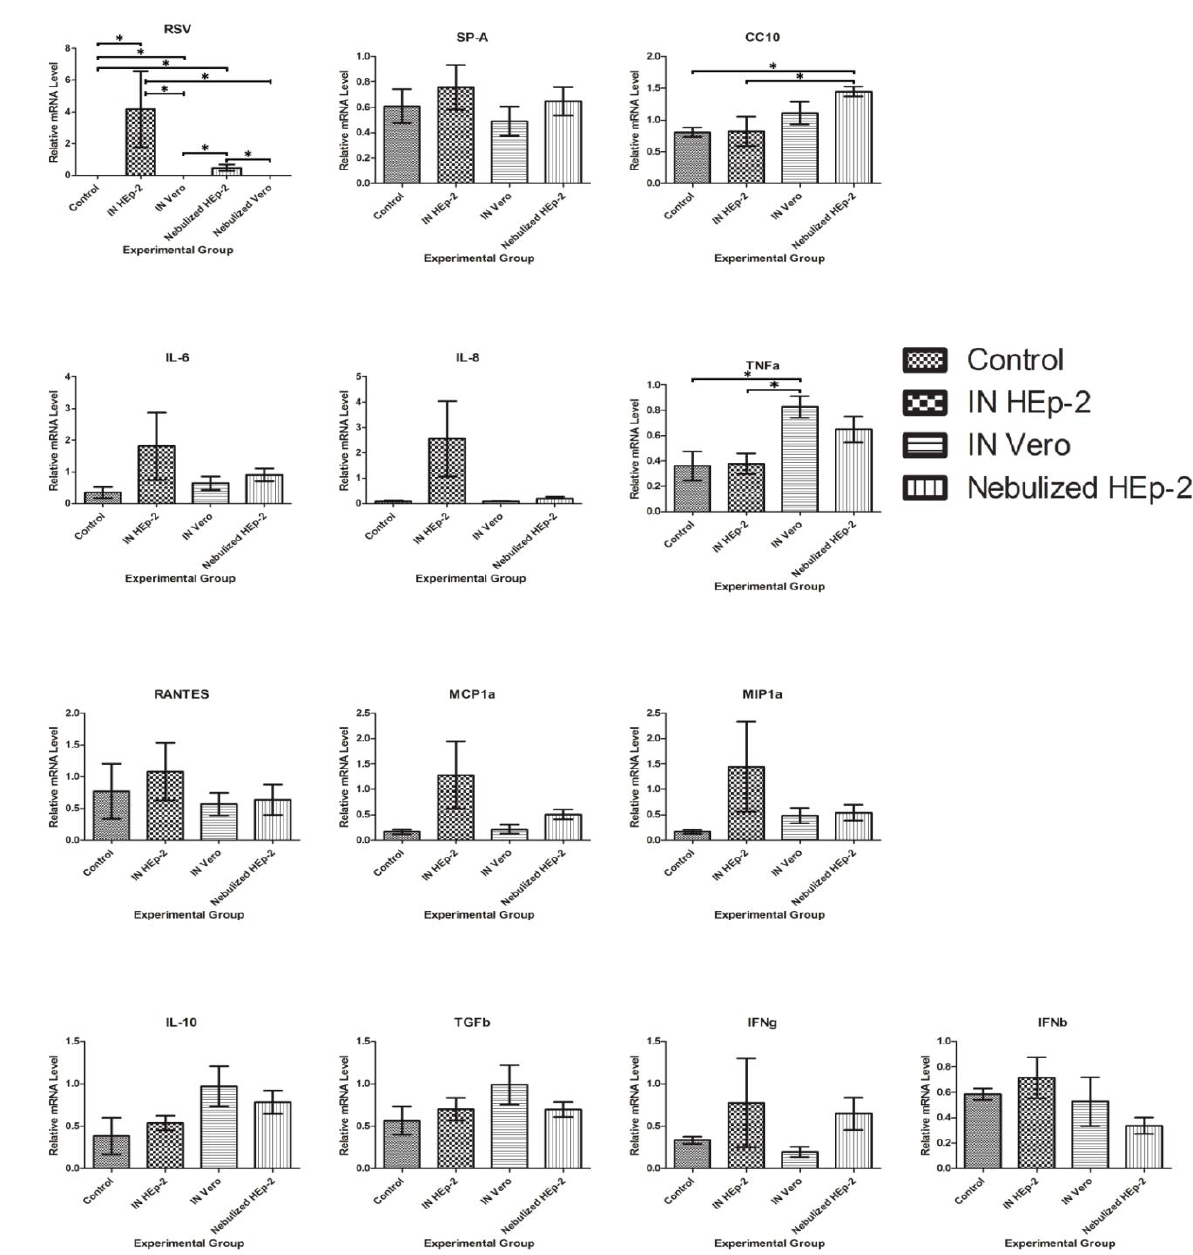
immune and inflammatory mediator targets, relative to standard curve. Significant differences between groups ( p < 0.05) are represented by a (*). Clara cell secretory protein (CC10), surfactant protein A (SP-A), interleukin 6 (IL-6), interleukin 8 (IL-8), interleukin 10 (IL-10), macrophage inflammatory protein (MIP-1α), monocyte chemotactic protein (MCP1α), tumor necrosis factor alpha (TNF-α), transforming growth factor beta (TGF-β), interferon beta (IFN-β), interferon gamma (IFN-γ), and regulated on activation normal T cell expressed and secreted